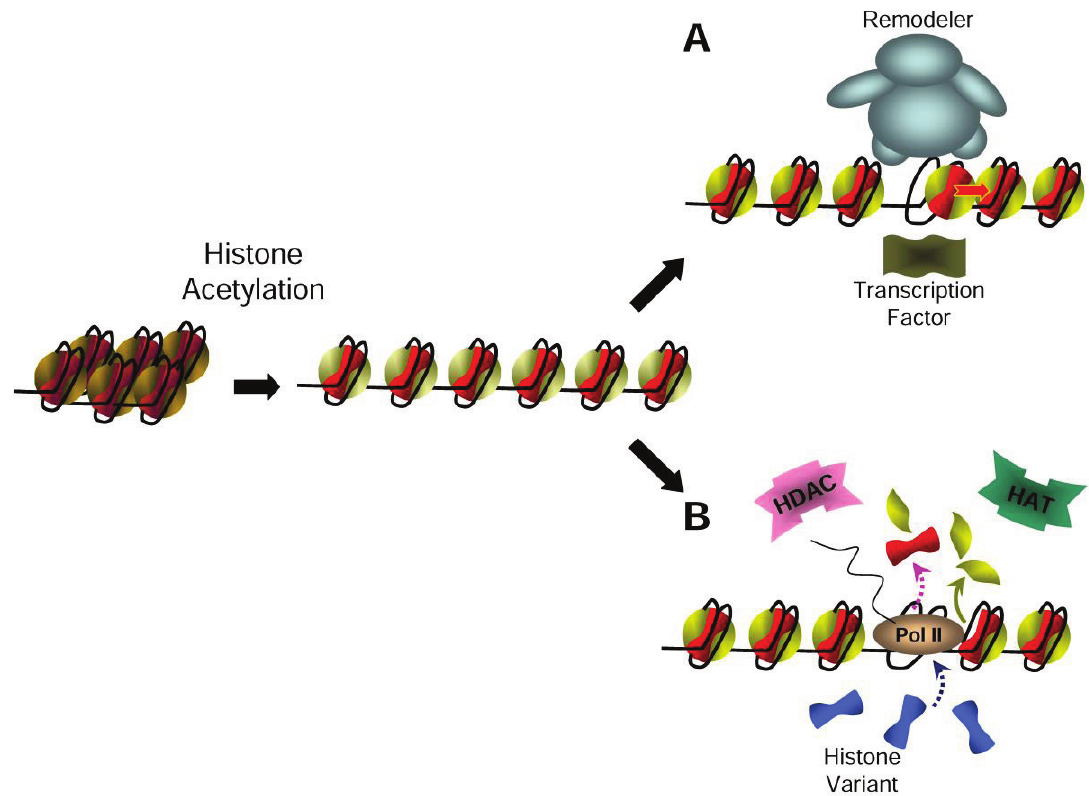
Figure 2. Model of the effects of histone acetylation on chromatin structure and dynamics. The acetylation of histones induced a decrease in nucleosome stacking involving chromatin remodeling at the promoter level ( A ) and within the coding region ( B ). Notably, the relaxation of chromatin in ( A ) can be promoted by HAT activity associated with transcription factors. In ( B ) the dashed arrows correspond to stochastic events such as octamer exchange, in contrast to the exchange of the H2A/H2B histone dimer, which is mechanistically linked to RNA polymerase II passage through the nucleosome (green